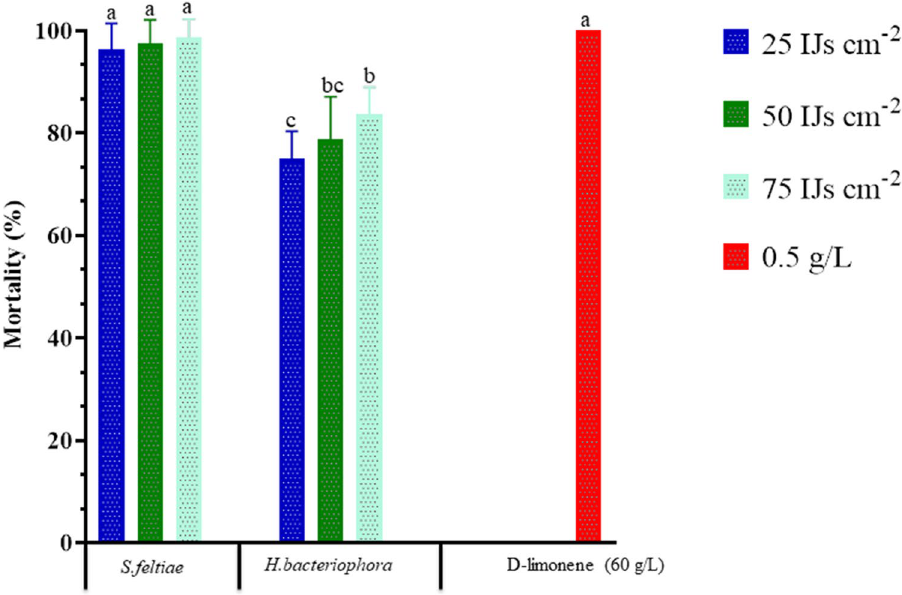
Figure 1. Comparative efficiency of two entomopathogenic nematodes isolates Steinernema feltiae and Heterorhabditis bacteriophora with d-limonene against Dactylopius opuntiae nymphs, in laboratory assay. Datasets are the mean of two independent trials with four relicates. Treatments with the same letter are not significantly different according to Tukey’s LSD test at P < 0.05.